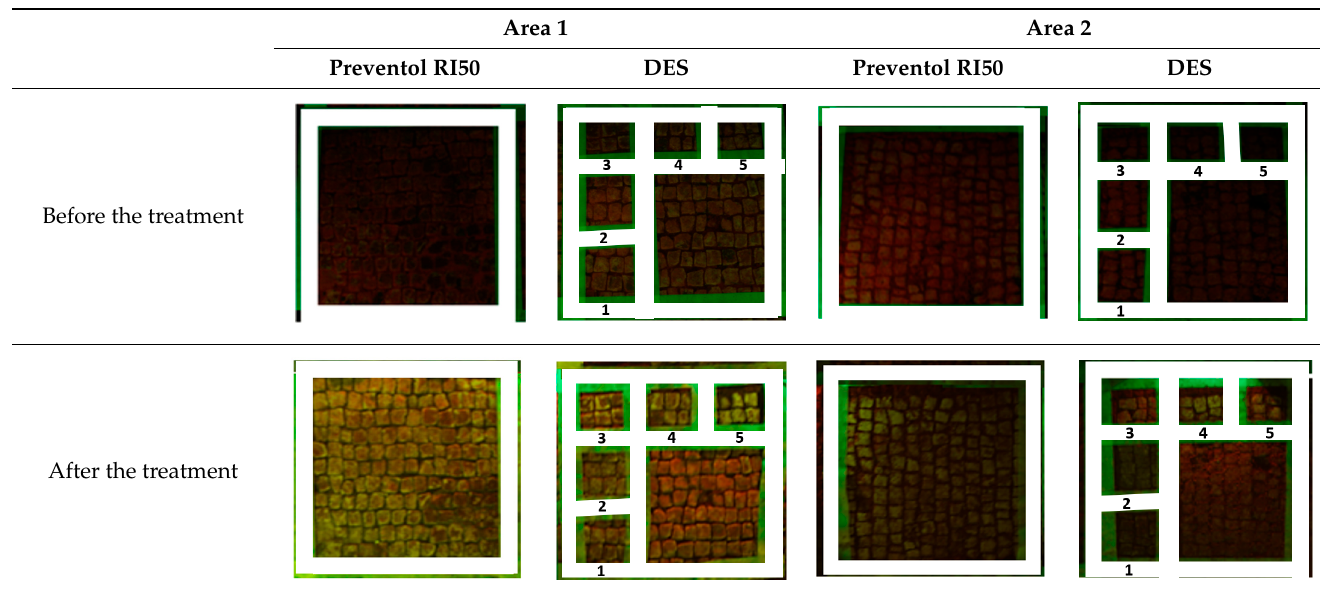
Table 2. Ultraviolet fluorescence imaging of Areas 1 and 2, before and after treatment with DESs and Preventol RI50.